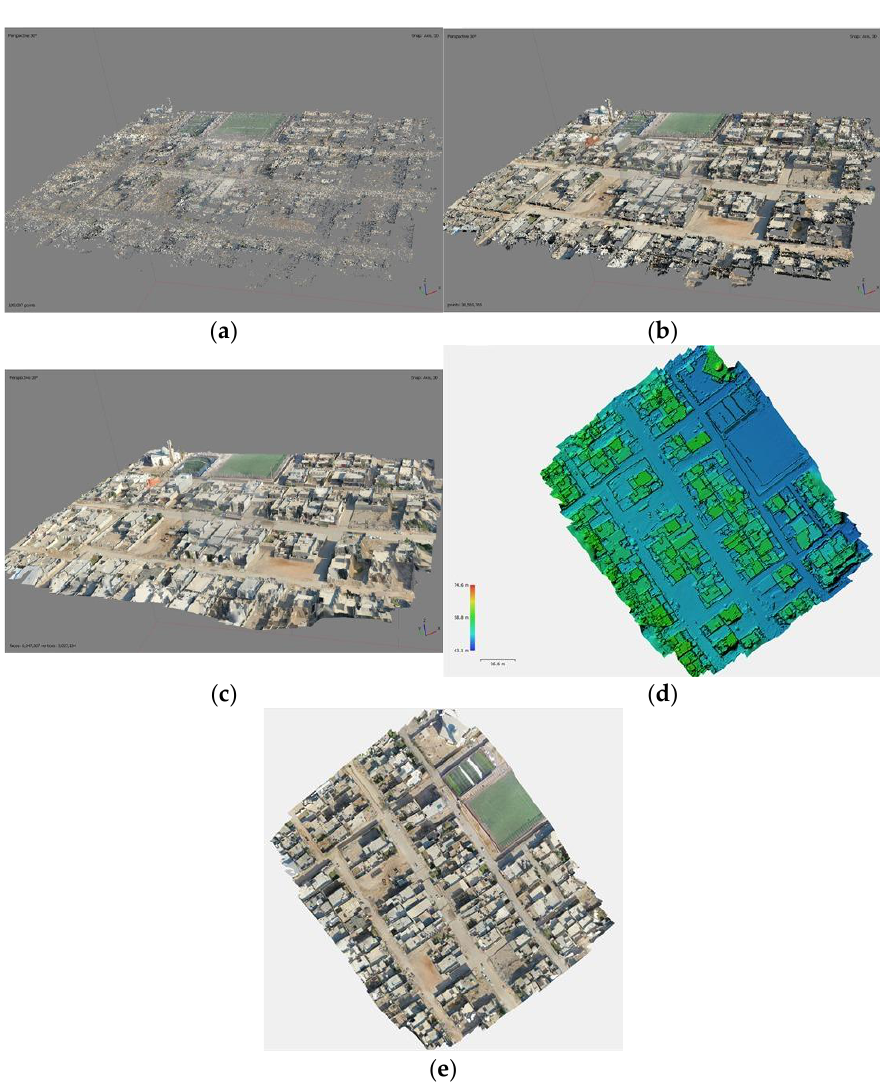
Figure 13. Geospatial products for the eleventh case: ( a ) sparse point cloud, ( b ) dense point cloud, ( c ) 3D model, ( d ) DEM, ( e ) orthophoto mosaic.